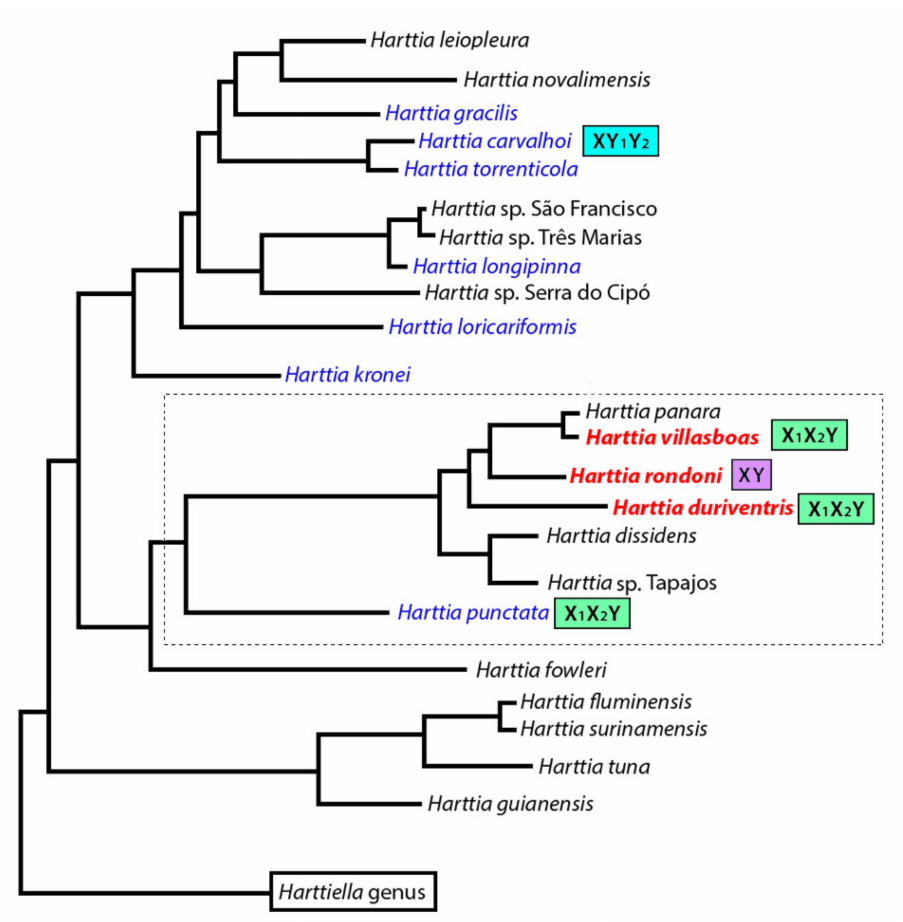
Figure 7. Adapted phylogenetic tree for the genus Harttia , based on the molecular-phylogenetic data generated by Covain [19]. Previous and now cytogenetic analyzed species are indicated in blue and red, respectively. The multiple X 1 X 2 Y (green boxes) and XY 1 Y 2 (blue box) sex chromosome found in Harttia is also indicated, together with the putative proto or neo XY system (purple box). Species from northern Brazilian region are highlighted with the dotted